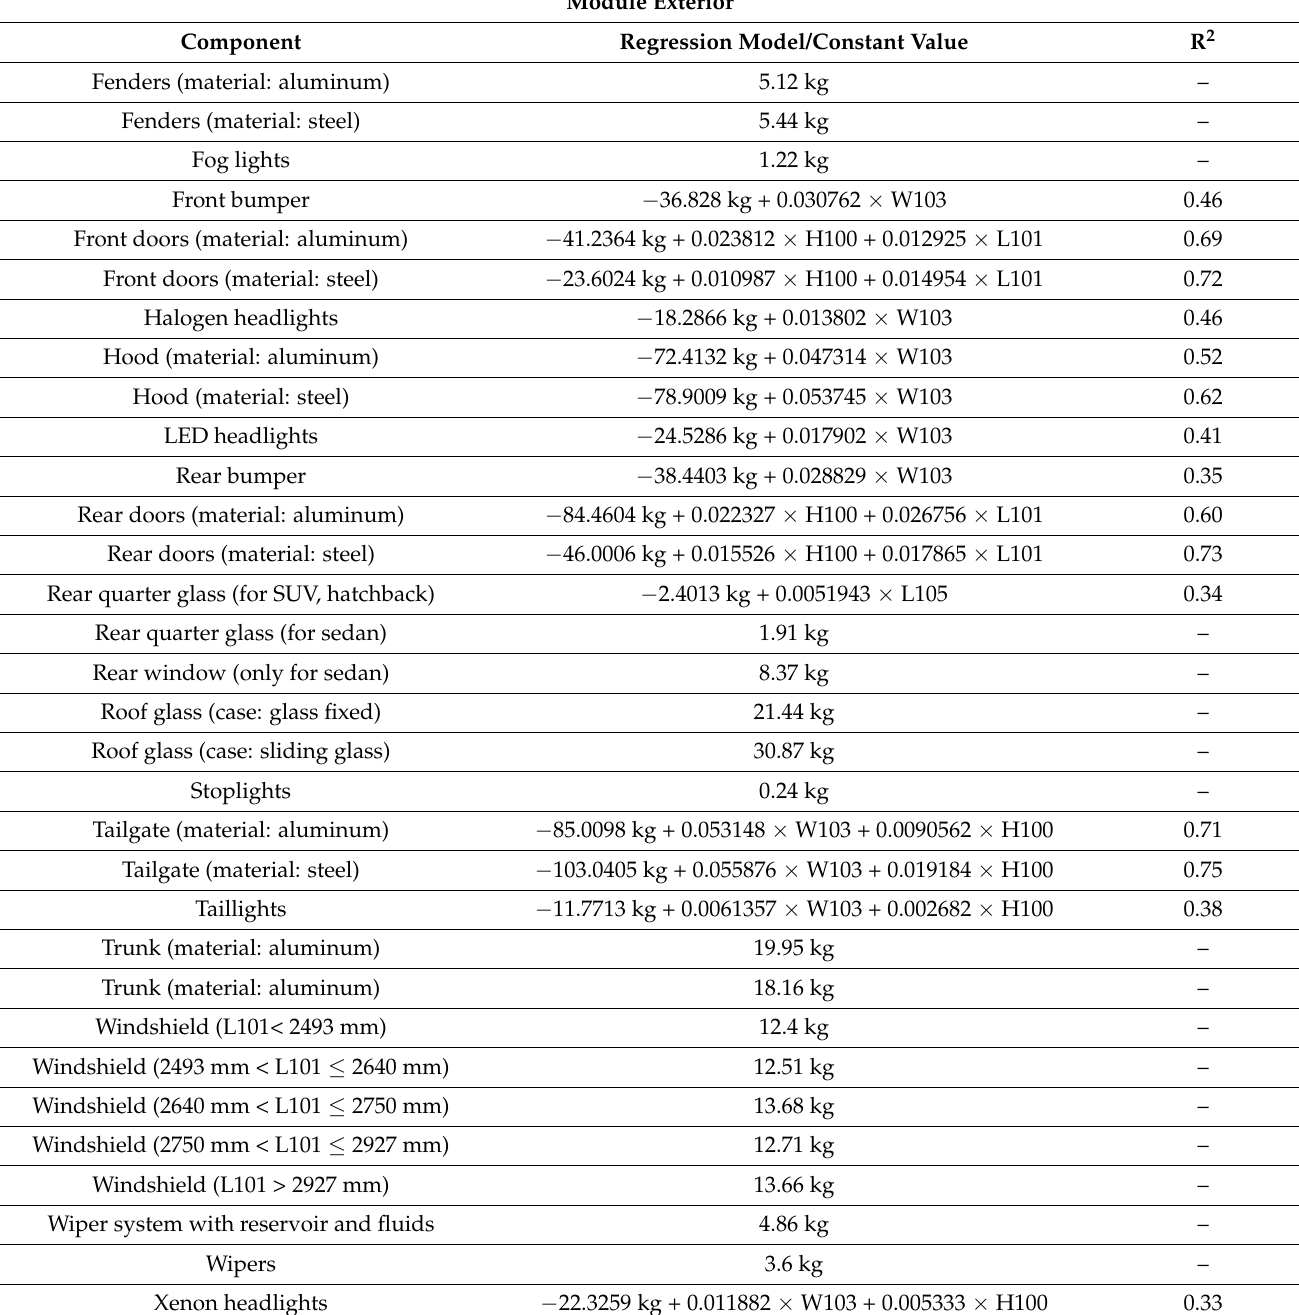
Table A6. Empirical models for the Exterior